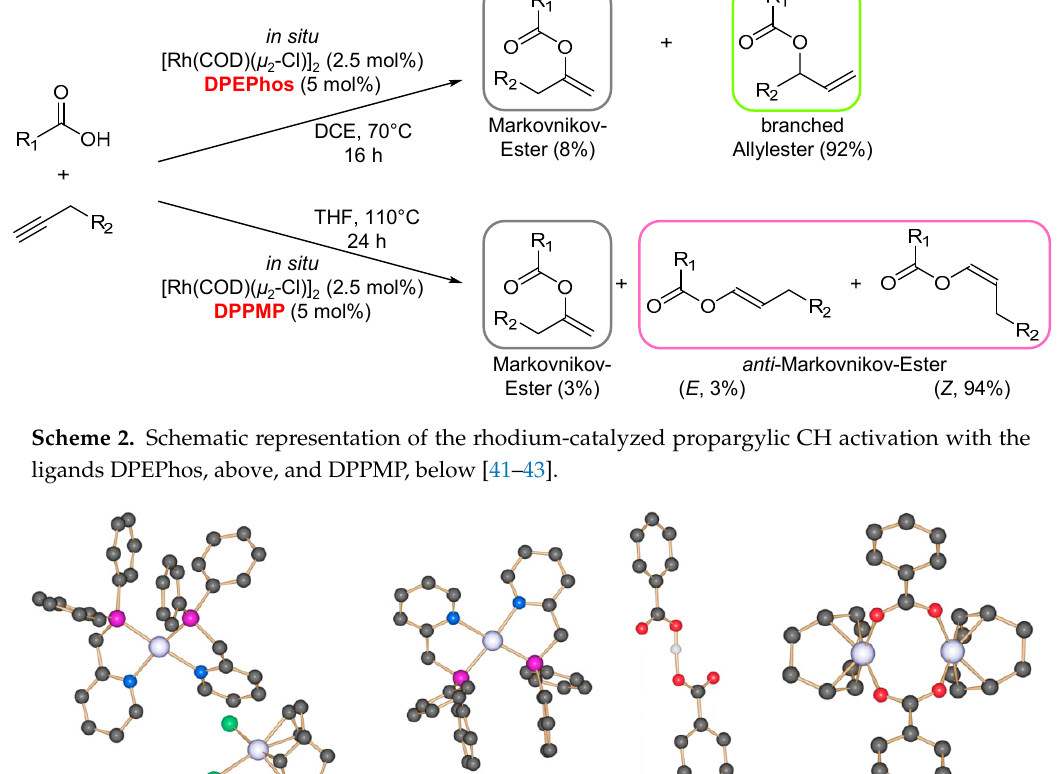
Figure 1. Molecular structure of [Rh(DPPMP) 2 ][Rh(COD)Cl 2 ], left, molecular structure of [Rh(DPPMP) 2 ][H(benzoate) 2 ] and [Rh(COD)( µ 2 -benzoate)] 2 , right. Hydrogen atoms (except H (benzoate) 2 ) are omitted for clarity